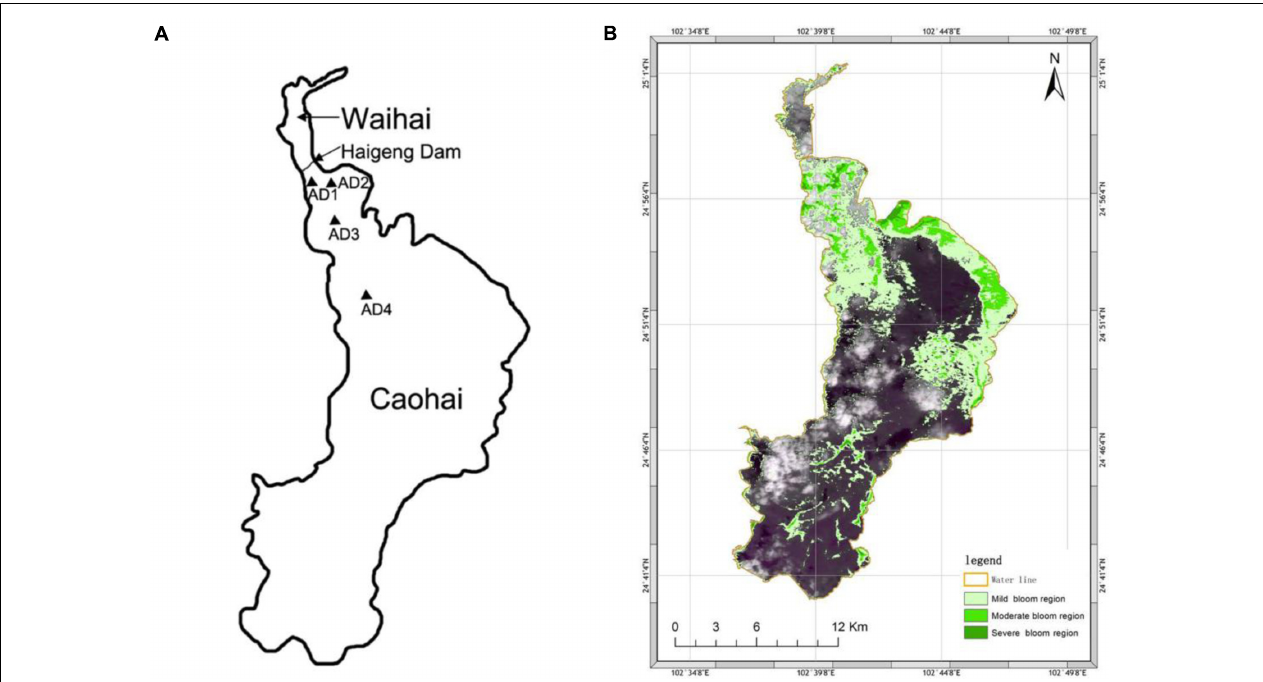
FIGURE 1 | Sampling location (A) and bloom area distribution (B) of Dianchi Lake during sampling. Sites are marked with triangular icons in